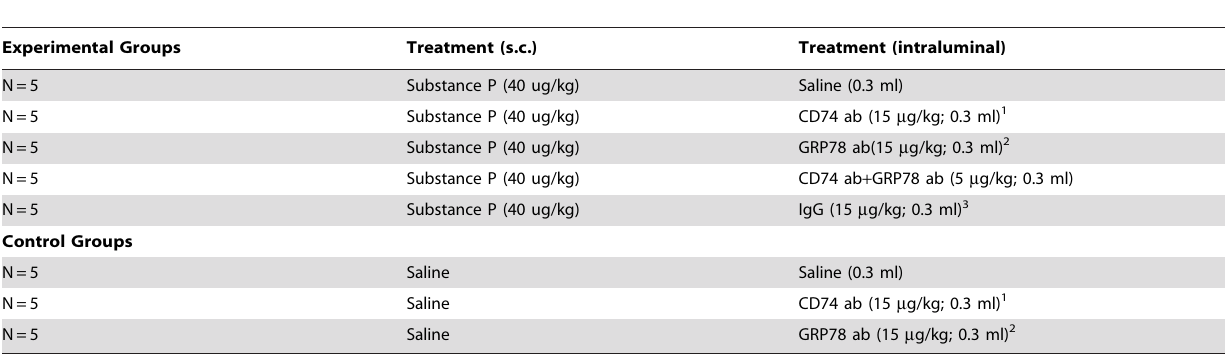
Table 1. Experimental design for different intraluminal treatments and their effects on substance P-induced bladder inflammation.